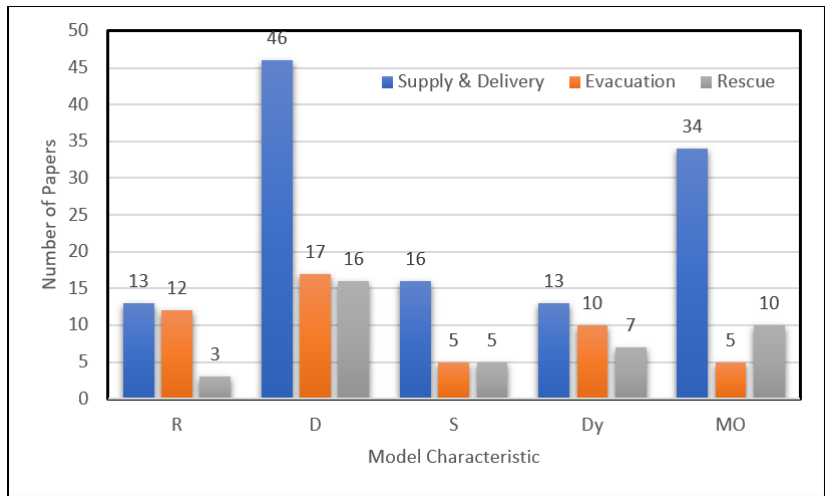
Figure 16. Selected Humanitarian Operation based on Model Characteristic.